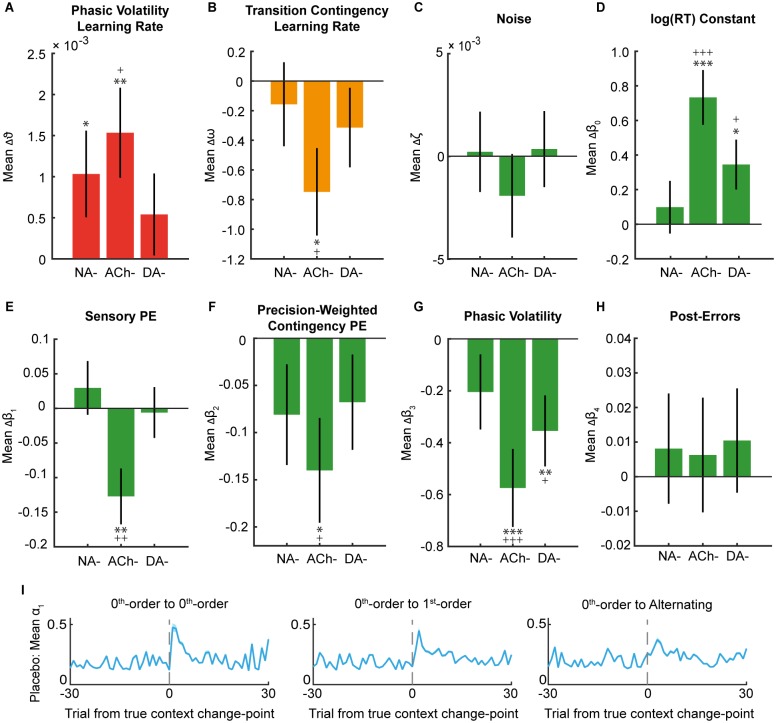
Model parameter results.(A–H) Compared to the Placebo group, NA and ACh antagonism modulated participants’ perceptual belief updating. NA- increased the rate at which participants updated their volatility estimates (increased ϑ). ACh- decreased the rate at which participants learned about stimulus contingencies (decreased ω) and increased participants’ ϑ estimates. DA- antagonism decreased the sensitivity of participants’ trialwise responses to their phasic volatility estimates (β3). DA- and ACh- antagonism also caused some general response slowing (β0). The three drug groups and the Placebo group showed equivalent post-error slowing (β4) and Gaussian noise (ζ). Results are (mean Drug) − (mean Placebo), ± the standard error of the difference (SED) between the means of the two samples and corrected for the covariates Δalertness and body weight. For uncorrected comparisons: * p < 0.05, ** p < 0.01, *** p < 0.001. For corrections for three comparisons, +’s are used for Benjamini-Hochberg-corrected significance thresholds at +
p < 0.05, ++
p < 0.01, +++
p < 0.001. See S2 Table for Placebo group means. (I) First-level learning rate (α1) trajectories for truly occurring trials from the Placebo group. Increases in α1 are observed following a true change in context. This α1 increase is amplified for a more obvious switch from one easy-to-detect zeroth-order context to a different zeroth-order context. In contrast, a switch to an alternating context, which is trickier to detect, is accompanied by a modest, more gradual increase in α1. Results are mean ± SEM. http://dx.doi.org/10.6084/m9.figshare.3796407.v1.